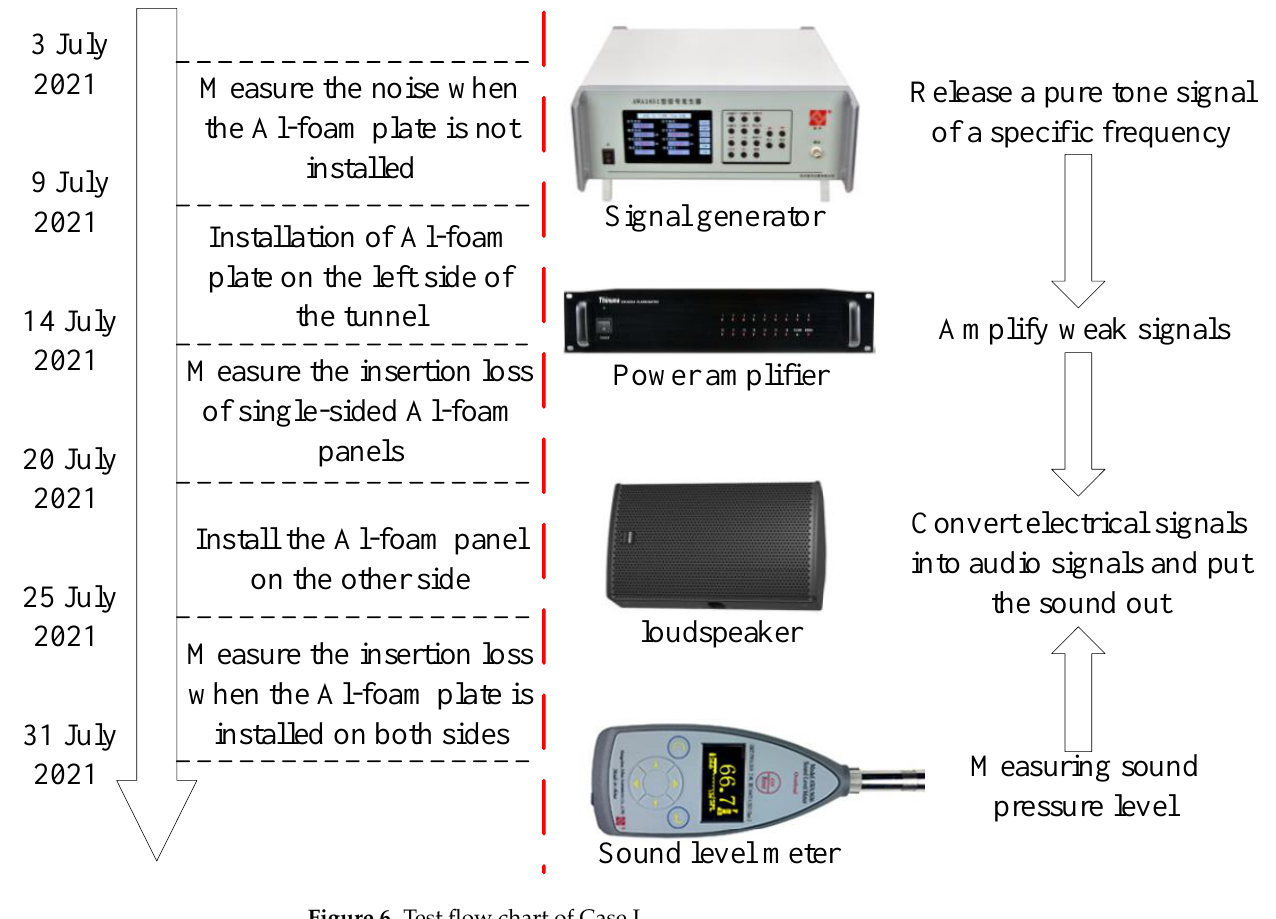
Figure 6. Test flow chart of Case I.